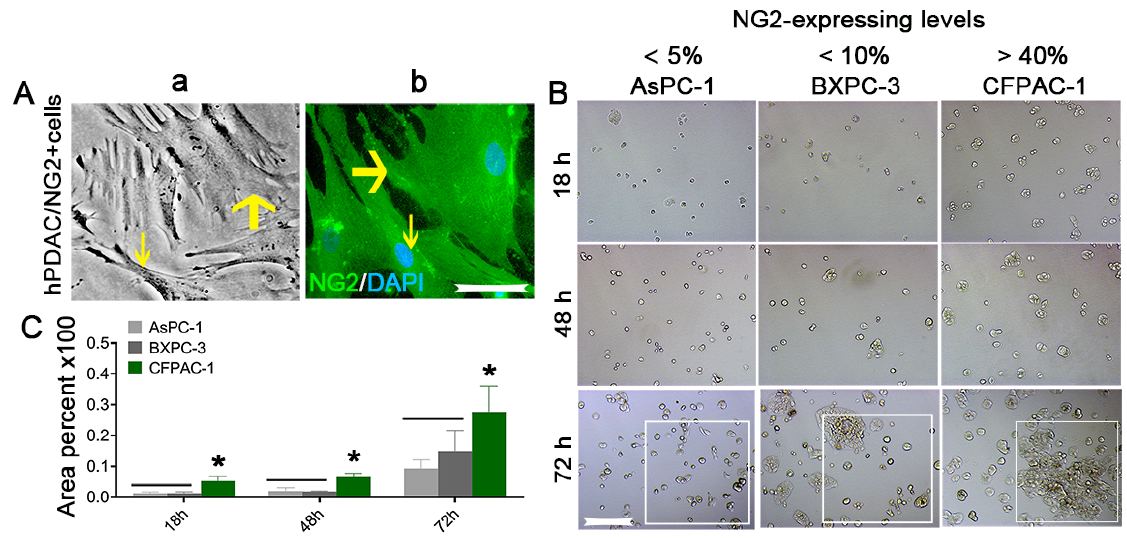
Figure 5. Heterogeneity and proliferative potential of isolated NG2/CSPG4 + -expressing cells (Figure 1, NG2 expression >40%). ( A ( a , b )) Exhibited heterogeneity (denoted as thin and bold arrows) of NG2/CSPG4-expressing cells freshly isolated from human PDAC tissues in primary cultures ( Aa ) and immunofluorescence staining ( Ab ). Scale bar = 200 µm. ( B ) Three human PDAC cell lines with different NG2 expression levels showed different growth potentials in cultures, as identified by a CCK8 assay. Scale bar = 100 µm. ( C ) Quantification of the proliferation of the three cell lines. At least three independent experiments were performed, and all data are presented as the mean ± SD. * p < 0.05 vs. the BXPC-3 and AsPC-1 cell lines.